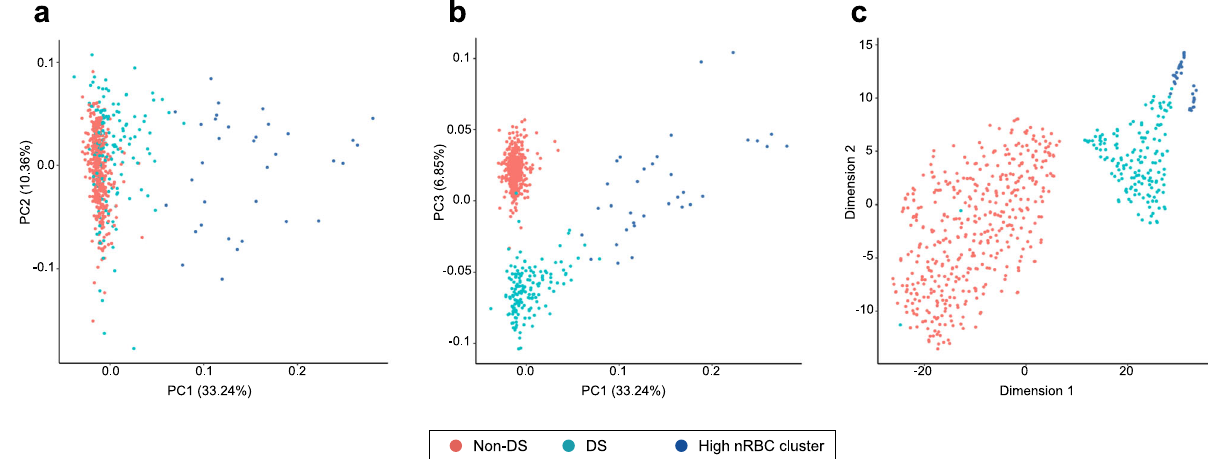
Fig. 1 Principal components analysis (PCA) and t-distributed stochastic neighbor embedding (t-SNE) plots of blood-based DNA methylation data in Down syndrome (DS) and non-DS newborns. PCA and t-SNE plots were generated in R, using “ prcomp ” and “ Rtsne ” functions, respectively, using genome-wide DNA methylation data from Illumina In fi nium EPICmethylation Beadchip arrays in 196 DS (teal/blue) and 439 non-DS (red) newborns, excluding CpG probes on chromosomes X, Y, and 21. The fi rst three principal components (PC1, PC2, and PC3) explained 33.2%, 10.4%, and 6.9% of the variance, respectively. a Per-sample data for PC1 plotted against PC2. b PC1 versus PC3. DS newborns with high PC1 values also had high proportions of nucleated red blood cells (nRBCs) in deconvolution analyses; this cluster of 34 DS newborns is highlighted by the blue-colored circles in both plots. PC3 appears to be related to trisomy 21 status. c First and second t-SNE dimensions for DS (teal/blue) and non-DS (red) newborns. The cluster of 34 DS newborns with high nRBC proportions is highlighted by the blue-colored circles. Two DS newborns clustered with non-DS newborns in the PCA and t-SNE plots, and these were subsequently found to be likely mosaic for trisomy 21 (see Supplementary Fig.